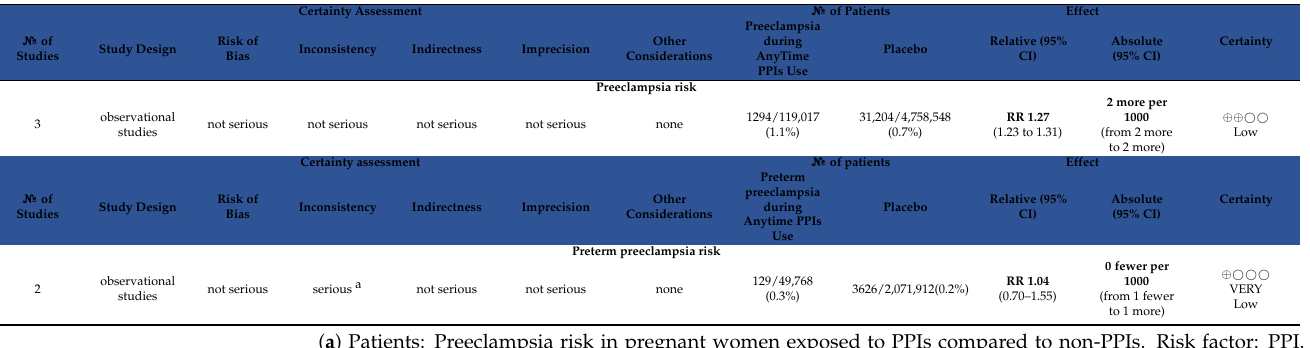
Table 4. ( a ) Summary of the findings table showing the certainty of the evidence for preeclampsia risk in women exposed to PPIs (anytime during pregnancy) compared to non-PPIs. ( b ) Summary of the findings table showing the certainty of the evidence for preterm preeclampsia risk in women exposed to PPIs (anytime during pregnancy) compared to